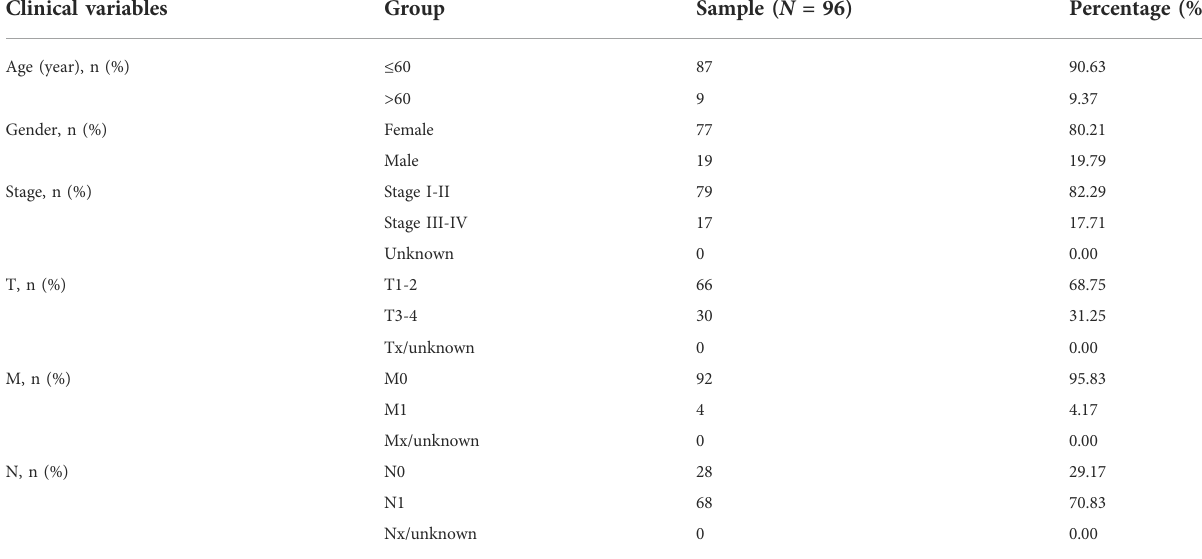
TABLE 2 The clinicopathological features of PTC ( N = 96).